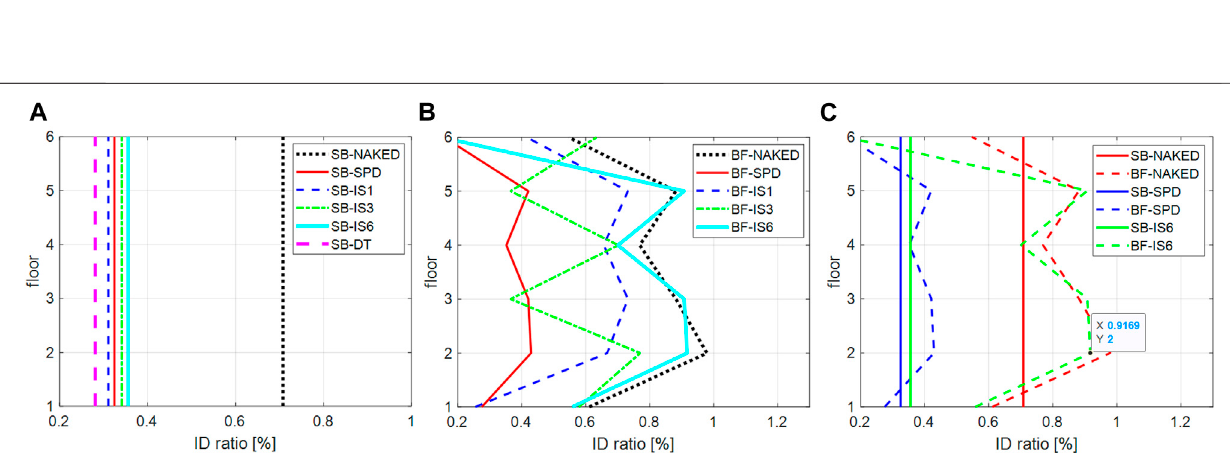
FIGURE 7 | (A) Time-history response from snap-back test for the damped SB systems; (B) Time-history response from snap-back test for the BF systems.